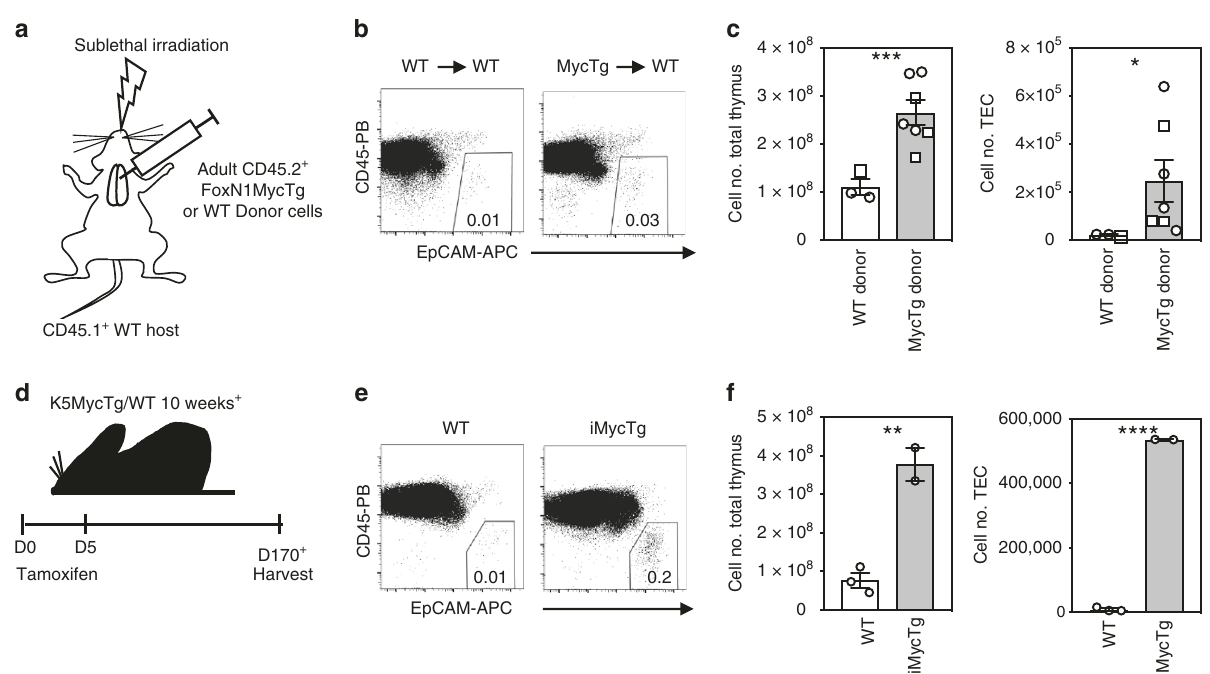
Fig. 7 Transgenic Myc expression in adult TEC confers fetal properties and can drive thymic regeneration. a Schematic of the experimental design of intrathymic injections. b Representative fl ow plots of the frequency of CD45 − EpCAM + total TEC recovered from WT hosts receiving adult WT or FoxN1MycTg donor TEC. c Bar graphs display total cells in thymus (left) and CD45 − EpCAM + total TEC counts (right) from WT host thymi receiving WT (white) or FoxN1MycTg (gray) donor TEC. Bar graphs show mean ± SEM, where circles display experiment 1 and squares display experiment 2. d A schematic of the experimental design of tamoxifen induced Myc expression in TEC. e Representative fl ow plots of the frequency of CD45 − EpCAM + total TEC recovered from K5 − MycTg + (WT) or K5 + MycTg + (iMycTg) tamoxifen treated mice. f Bar graphs display total thymus counts or CD45 − EpCAM + total TEC counts from K5 − MycTg + (white) or K5 + MycTg + (gray stripe) tamoxifen treated mice. Bar graphs show mean ± SEM for a minimum n = 2 mice per genotype. A two-tailed unpaired Student ’ s t test was performed to determine signi fi cance. * p < 0.05, ** p < 0.01, **** p < 0.0001. The source data underlying ( c , f ) are provided as a Source Data fi